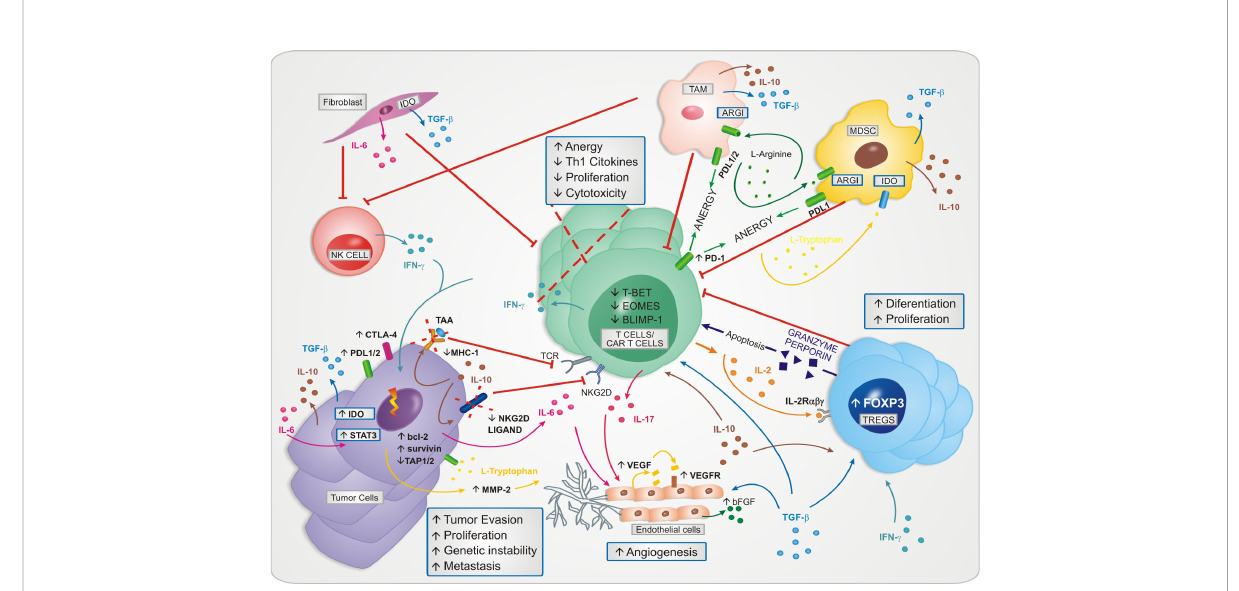
FIGURE 2 A representative scheme of CAR-T cell manufacturing platform. The de fi nition of equipment, steps and protocols used depend on the patient, the type of tumor and clinical